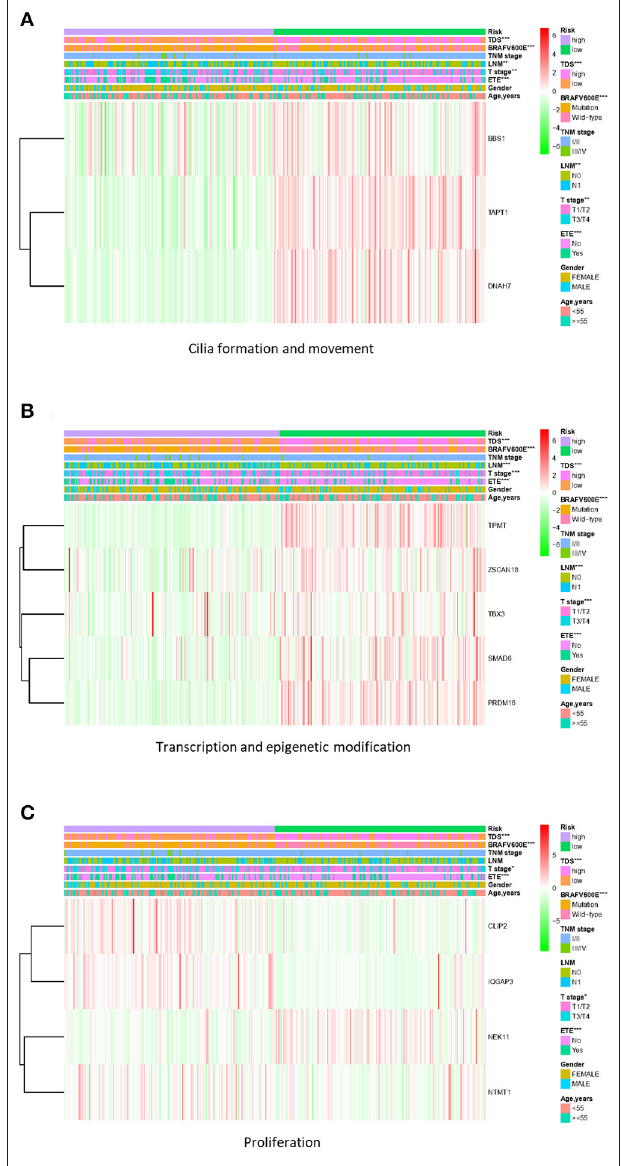
TABLE 3 | Clinicopathologics of PTC patients in TCGA cohort.